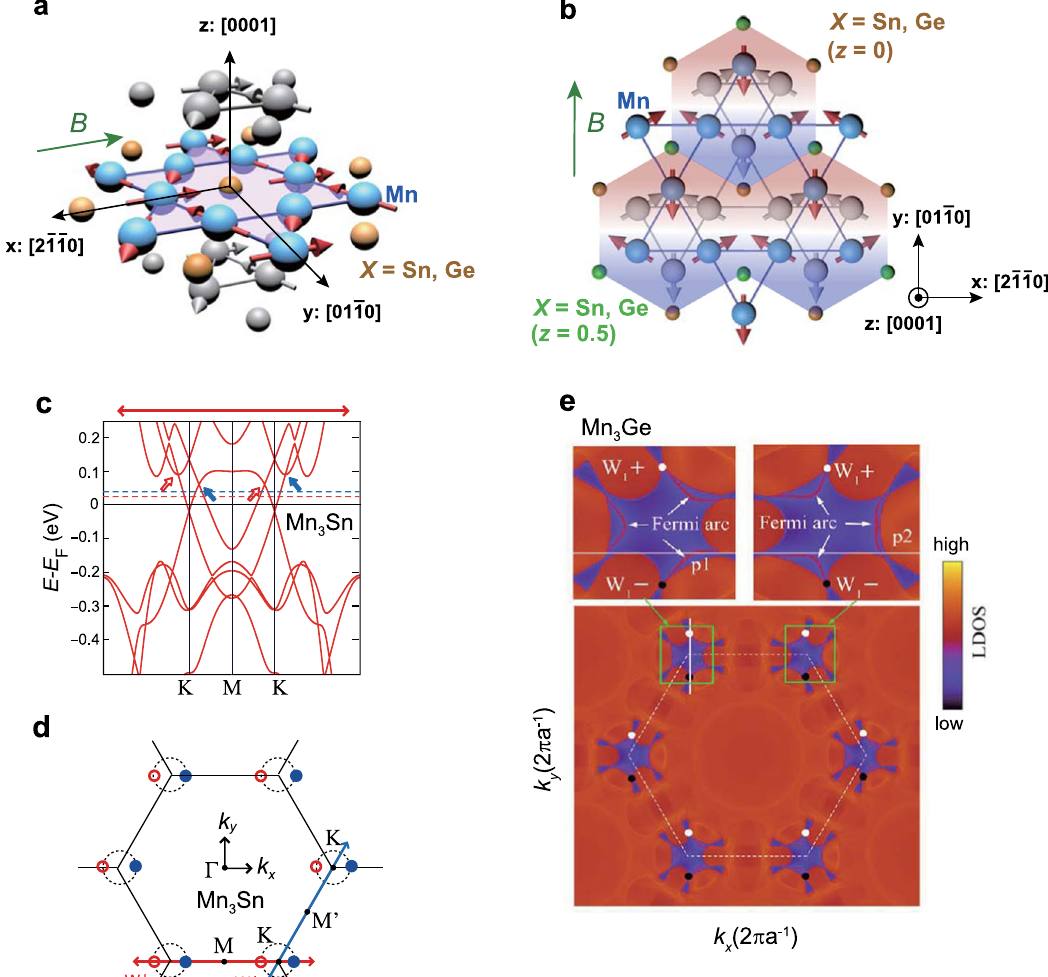
Fig. 1 Magnetic structure and theoretically predicted Weyl points of Mn 3 X ( X = Sn, Ge). a Crystal structure of Mn 3 X ( X = Sn, Ge) and the spin texture (cid:1) (cid:3) under a magnetic fi eld applied along the 2 (cid:1) 1 (cid:1) 10 direction. The Mn moments lying within the kagome (hexagonal ab ) plane form the inverse triangular spin (cid:1) (cid:3) (cid:1) (cid:3) order (colored in purple). Here, we de fi ne 2 (cid:1) 1 (cid:1) 10 , 01 (cid:1) 10 , and [0001] as the x -, y- , and z -axes, respectively. The colored atoms lie within the kagome plane at z = 0. The large (small) spheres in grayscale represent Mn (Sn or Ge) atoms forming kagome planes at z = ±1/2. b Schematic illustration of the cluster magnetic octupoles formed under an applied magnetic fi eld B || y . The arrows represent Mn magnetic moments that constitute the inverse triangular spin structure. The Mn moments on an octahedron made of two triangular units of adjacent kagome layers can be characterized by a cluster octupole moment (colored hexagons). The spin structure can then be considered as a ferroic ordering of cluster magnetic octupoles. c The calculated band structure along the K-M-K cut (solid lines) of Mn 3 Sn. The open and closed arrows, respectively, mark the opposite chirality ( + ) and ( − ) of the two low - energy Weyl point pairs, W 1 and W 2 (see the panel ( d )). The studied Mn 3 Sn samples are off-stoichiometric Mn 3.03 Sn 0.97 and Mn 3.06 Sn 0.94 ; the extra Mn shifts the chemical potential up in energy by 19 meV for Mn 3.03 Sn 0.97 (red dashed line) and by 40 meV for Mn 3.06 Sn 0.94 (blue dashed line) compared to the E F of the stoichiometric sample (black solid line). d Location of Weyl points in the k z = 0 plane of the hexagonal Brillouin zone (BZ) for electron bands near E F . Two groups of Weyl points W 1 and W 2 are shown. For each pair, the open and closed circles indicate positive ( + ) and negative ( − ) chirality, respectively. Rotation of an applied magnetic fi eld within the xy -plane may shift the position of the Weyl nodes along the hypothetical nodal ring (dashed circular curves). The present distribution of Weyl points corresponds to the magnetic structure of Mn 3 Sn shown in ( a ). e Calculated surface local density of state (LDOS) at E F of Mn 3 Ge that reveals the pair of Weyl points W 1 of opposite chirality (white and black dots) and the Fermi arcs marked as p 1 and p 2 . Adapted from ref. 8 , Springer Nature ( c , d ); and ref. 28 , IOP ( e